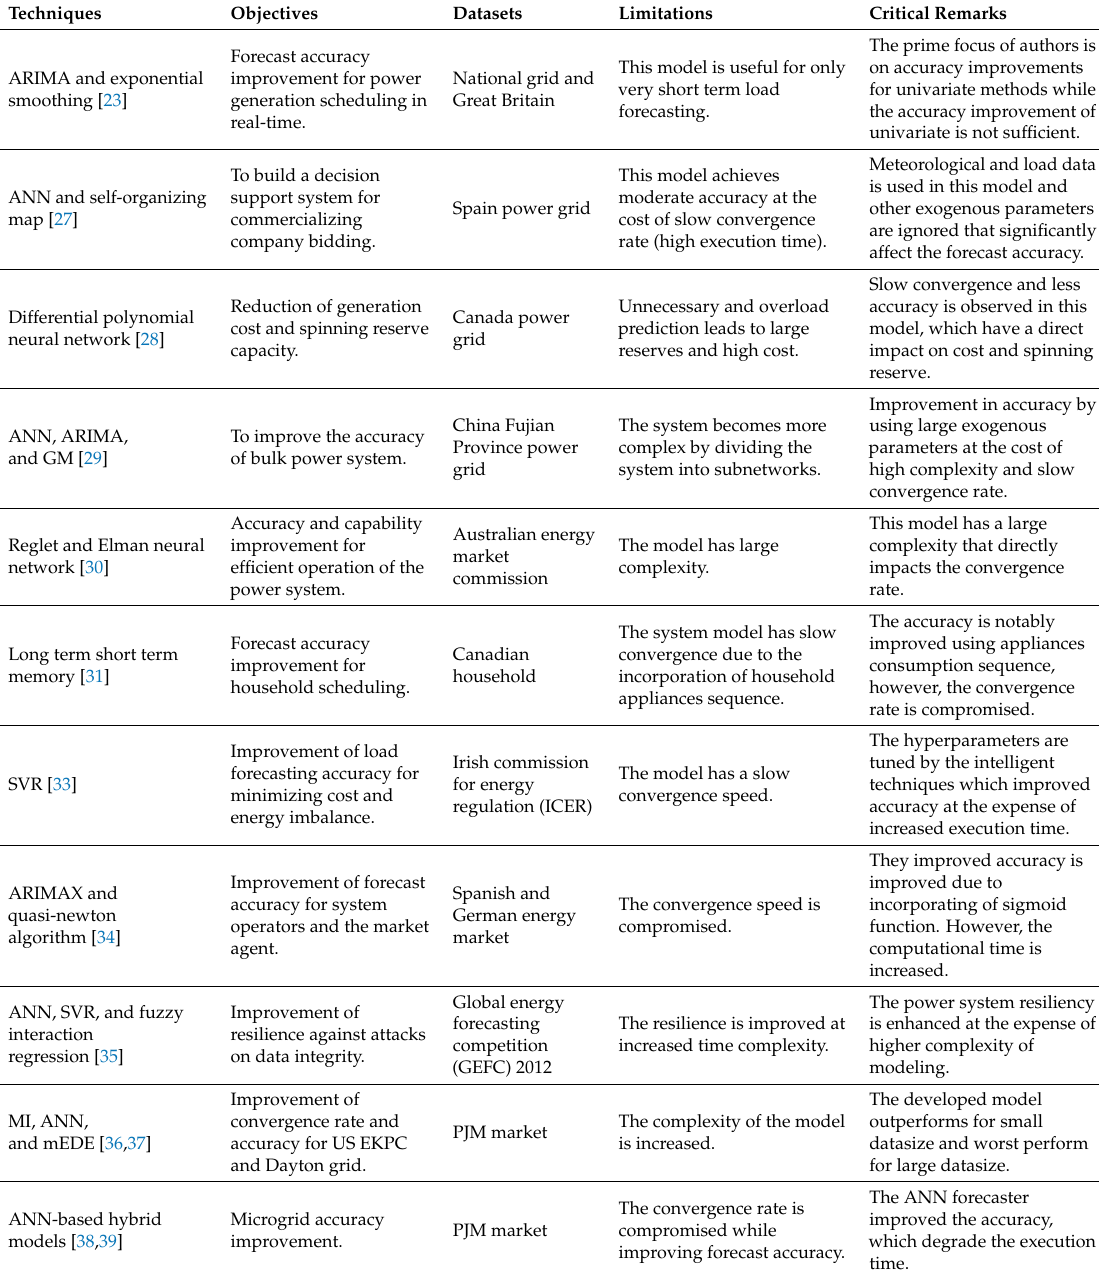
Table 1. Brief review of recent and relevant work in terms of techniques, objectives, datasets, limitations, and critical